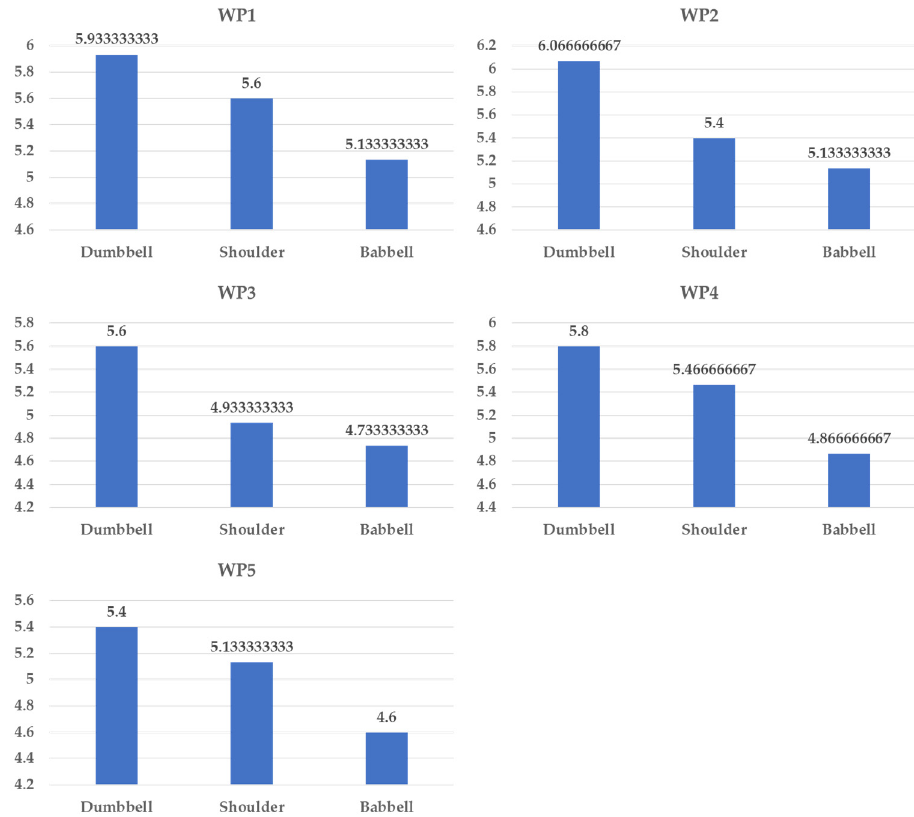
Figure 15. Results of the average points of the questionnaire for the evaluation of weight perception. Table 9. Results of the ANOVA test of the weight perception in Experiment 2.